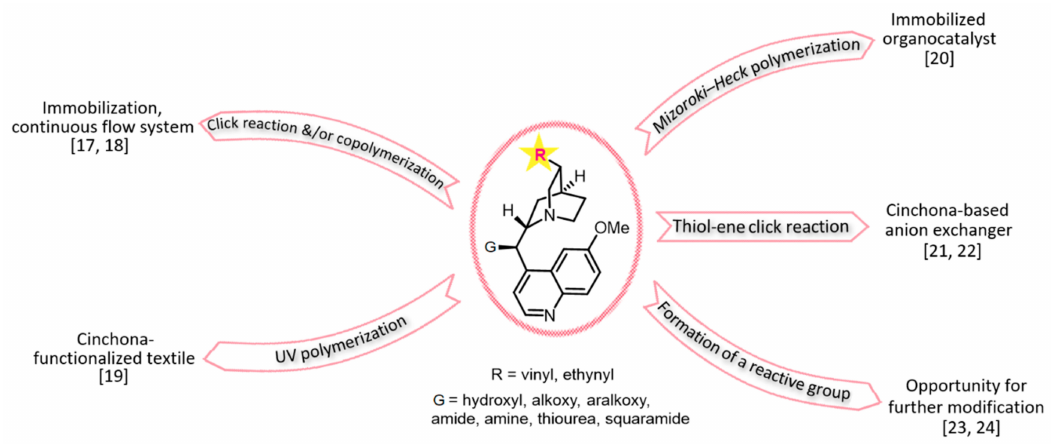
Figure 2. The possible direct modifications on the vinyl or ethynyl group of quinuclidine unit.